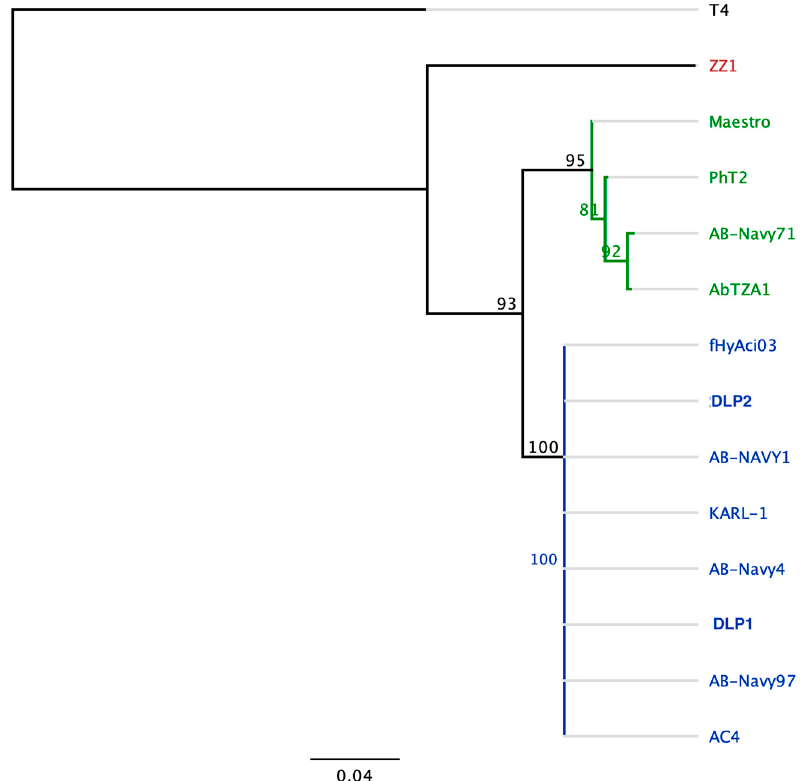
Figure 12. A rooted tree of the large terminase proteins of 11 published Acinetobacter T4-like phages. PHYML was used on a Clustal Omega alignment of the TerL protein, using Escherichia phage T4 to root the tree. Branch support is shown from 100 bootstrap replicates. Blue represents the Lazarusvirus clade, green represents the Hadassahvirus clade. Phage ZZ1 (red) forms the Zedzedvirus clade. Table 5. Comparison of T4-like A. baumannii phages published to